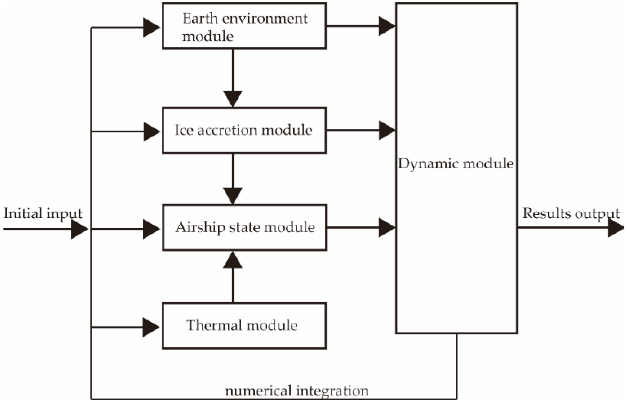
Figure 1. Simulation program module interactions chart.